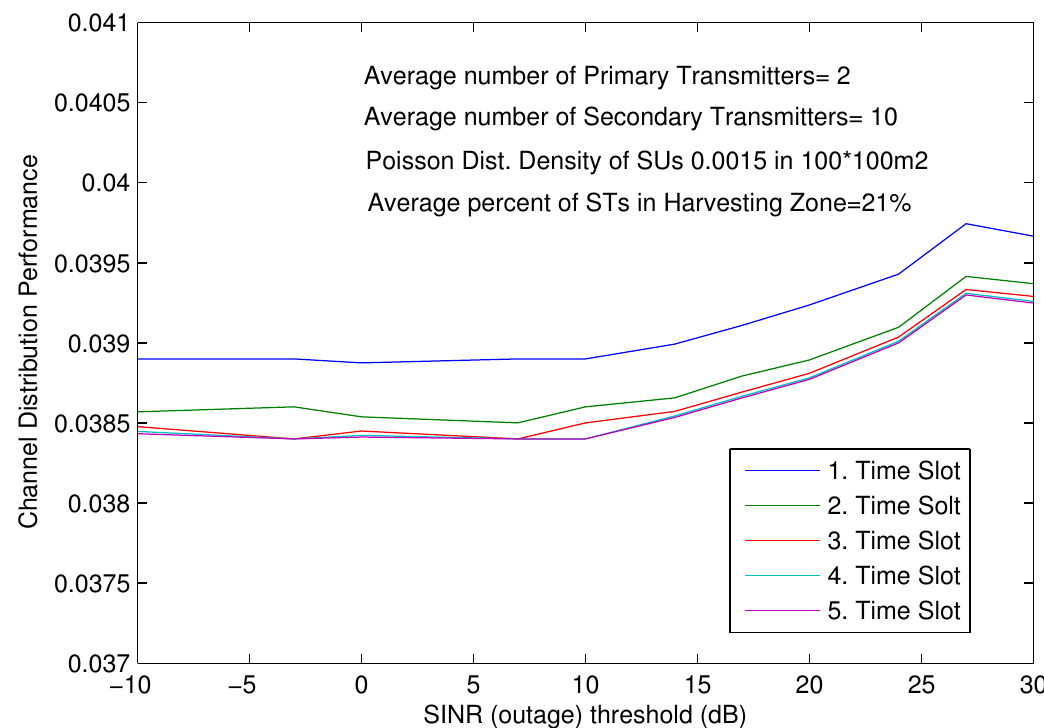
Figure 4. ChDistFairness against different SINR (threshold) values for Poisson distribution density of STs of 0.0015 on the area of 100 × 100 m 2 around the PT and average percentage of STs in harvesting zone of about